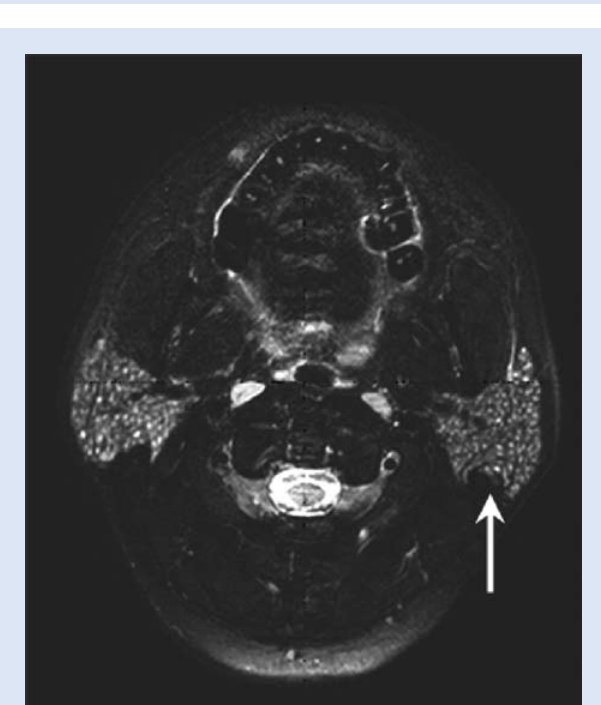
Fig. 3. Axial T2W fat-suppressed image with TE 110 ms, TR 5 200 ms. Note improved visibility of microcysts